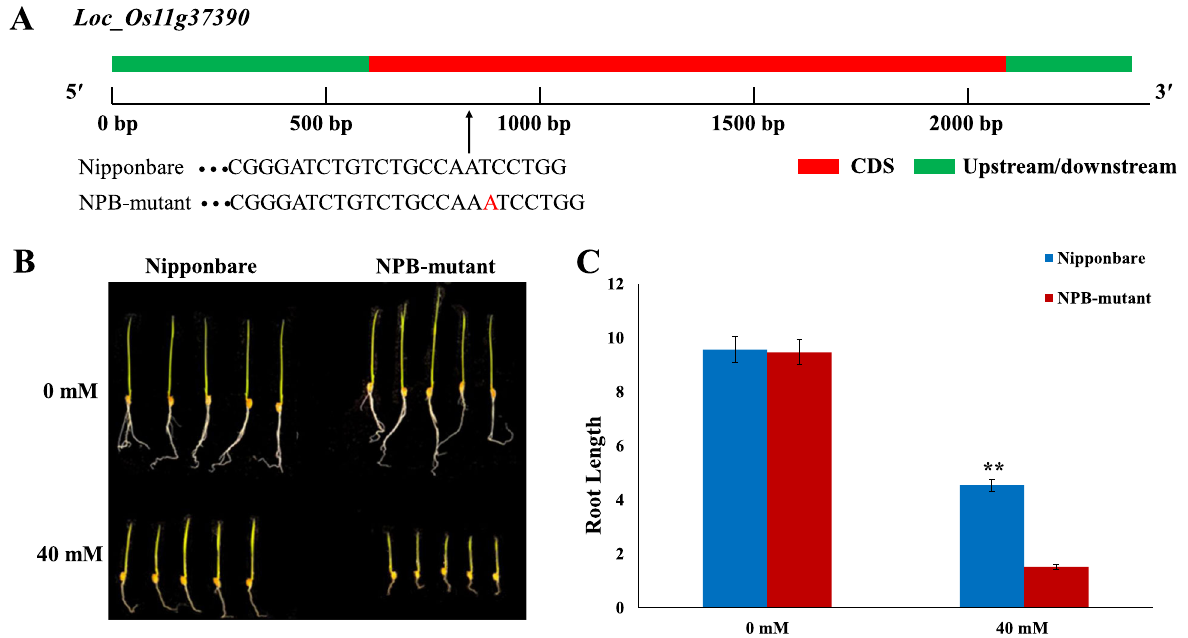
Fig. 6 a DNA sequence of LOC_Os11g37390 in Nipponbare and NPB-mutant. b Growth of NPB-mutant and control shoots treated with 0 or 40 mM NaHCO 3 for 10 days. c Significant differences in phenotypes between wild-type and NPB-mutant (** P < 0.01; Student ’ s t